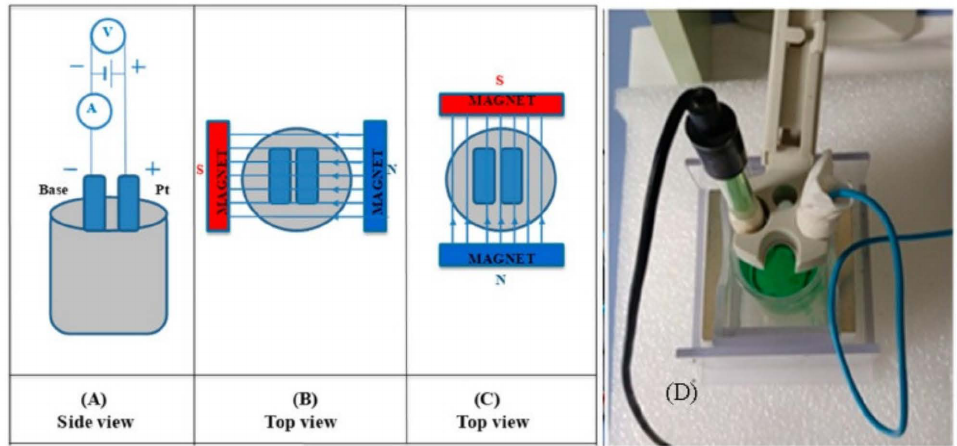
Figure 1. Schematic presentation of the deposition set-up: ( A ) without the EMF (side view); ( B ) per- pendicular orientation of the EMF (top view); ( C ) parallel orientation of the EMF (top view), in respect to the surface plane, and photo of deposition set-up ( D